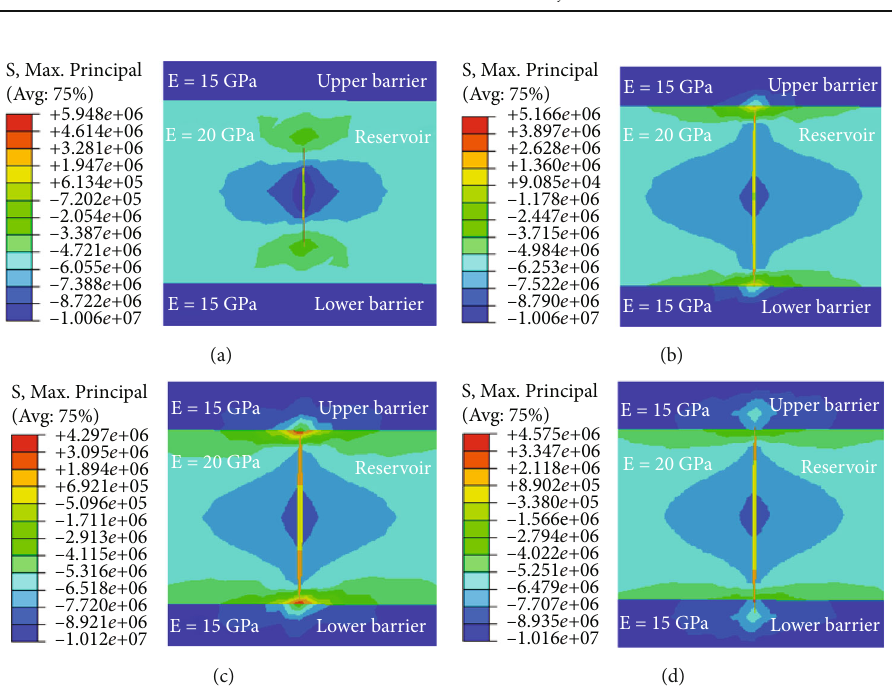
Figure 9: Hydraulic fracturing height for the base case at di ff erent times after the beginning of the fracturing process: (a) 10 steps, (b) 20 steps, (c) 40 steps, and (d) 50